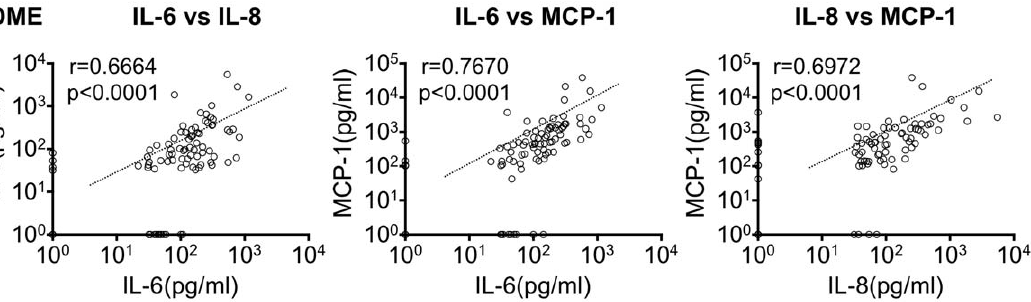
Figure 2. IL-6, IL-8 and MCP-1 were mutually increased in all examined vitreoretinal diseases. As an example, Spearman’s correlation analysis of DME are shown (n=92). In each disease, total of three combinations (IL-6/IL-8, IL-6/MCP-1, and IL-8/MCP-1) were created, and calculated p- and r-values which indicating the accuracy of correlation.